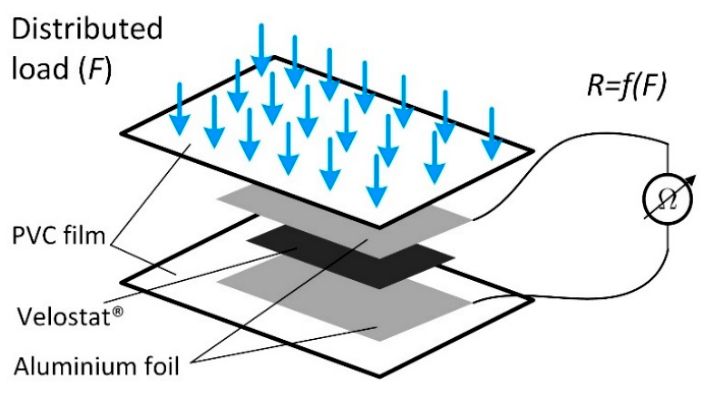
Figure 2. Structure of the developed wearable foot sensor.